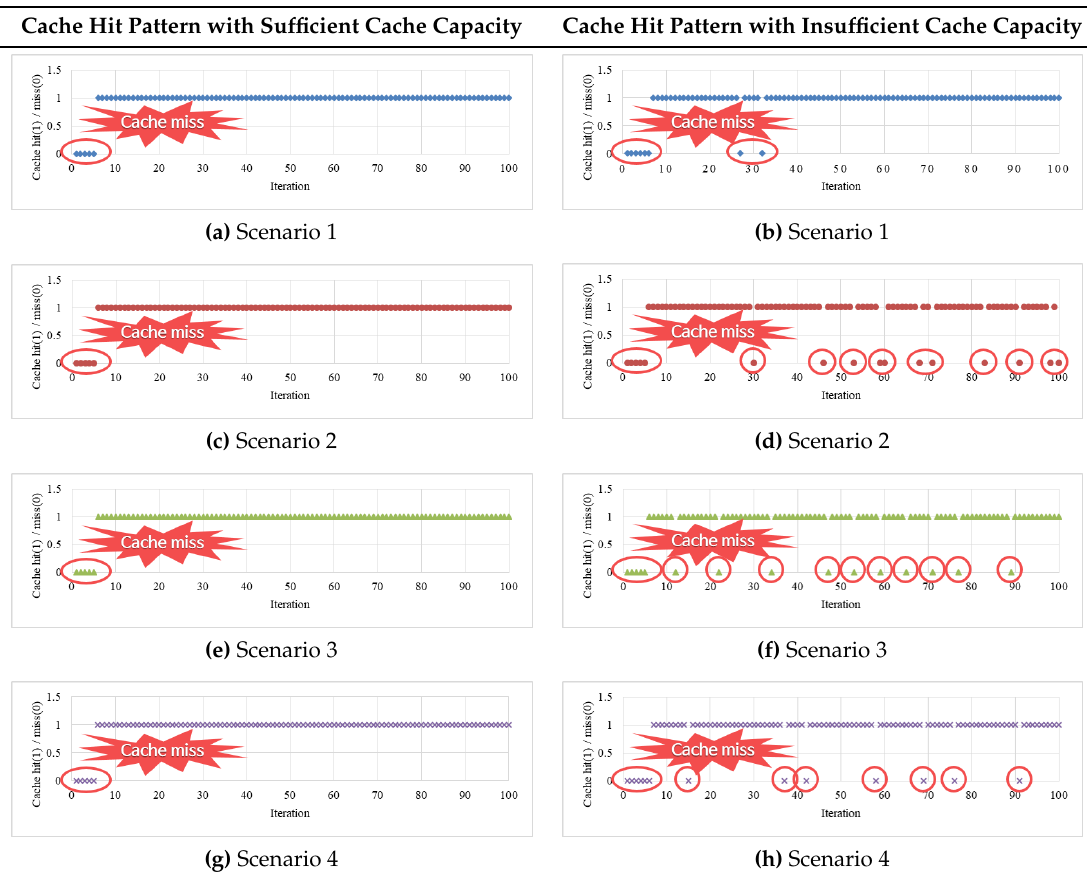
Table 8. Cache hit